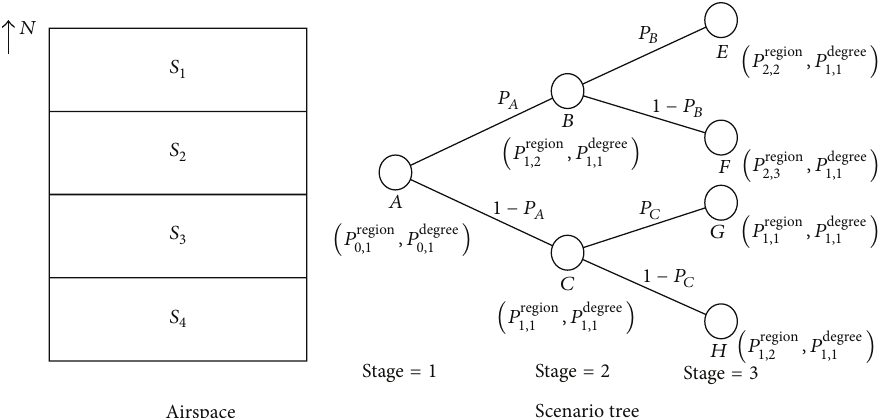
Figure 1: Demonstration of scenario